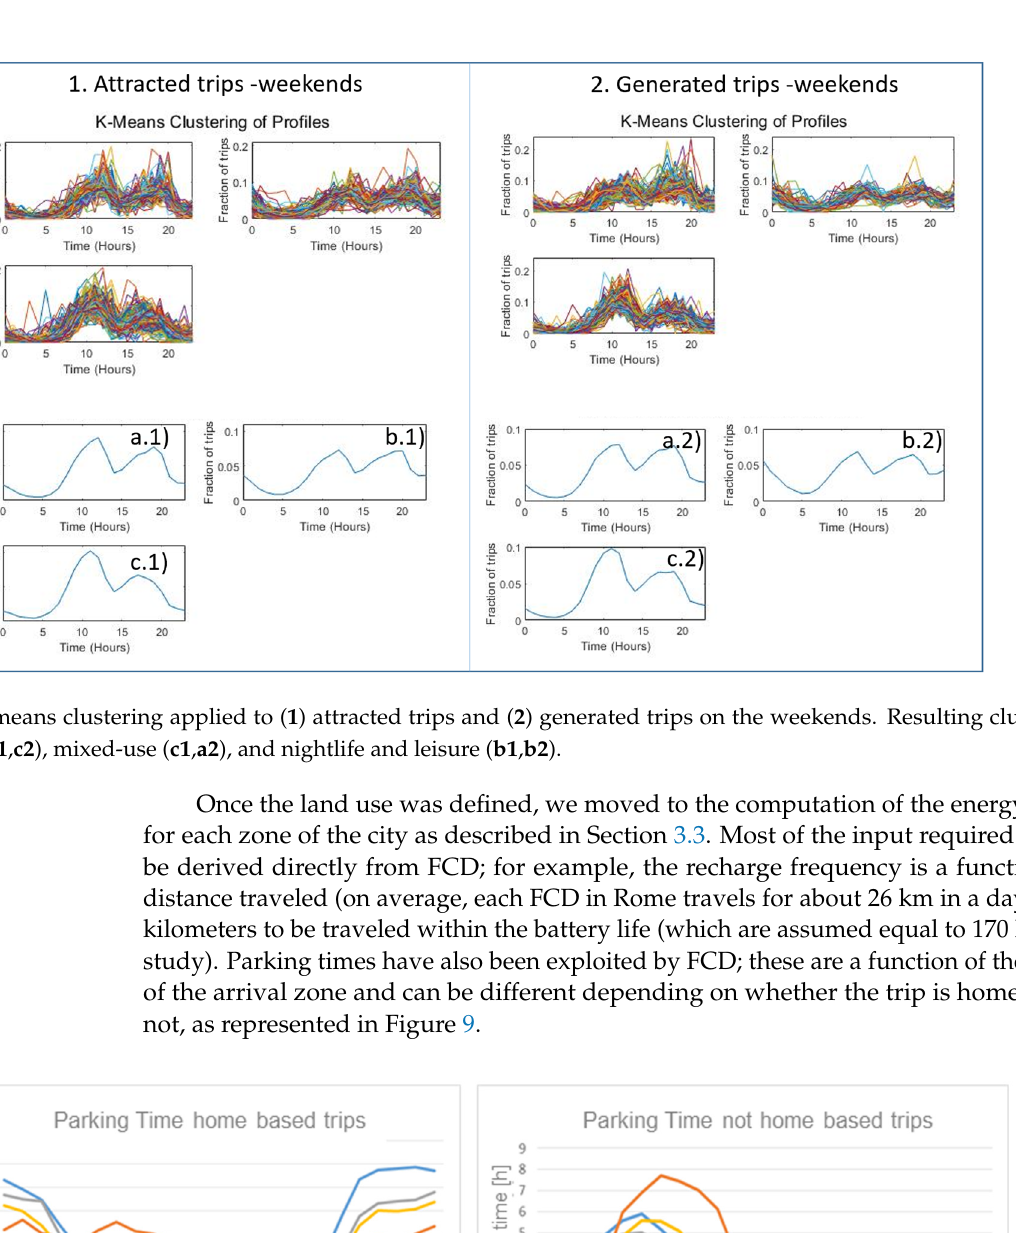
Figure 10. Examples of energy demand computation for two different land use zones in the city of Rome. 5. Discussion and Policy Implications The main research question explored in this work concerns how the future spread of EVs in urban areas can be tackled both from a mobility planning and an energy manage- ment perspective. Specifically, the proposed modeling framework is aimed to assess: (1) short-term measures driven by the characterization of the multimodal interchange be- tween public transport and electric private mobility; (2) medium- to long-term measures based on the evaluation of the EVs’ energy demand as a function of the land use. The models developed here are currently under testing inside an agent-based simu- lator for electric urban mobility adopted by the National Agency for Energy and Environ- ment in Italy (ENEA). Regarding multimodality, the Park and Ride module generates the changes in the Park and Ride demand in the different zones of the city as a function of possible scenarios. Two scenarios are now implemented in the simulator: (1) a scenario promoting the effi- cacy and effectiveness of the public transport network (thus a pull policy to increase the